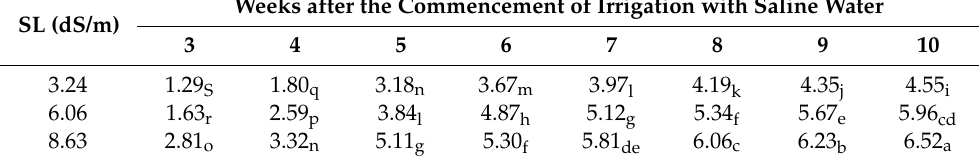
Table 5. Interaction effects of salinity levels (SLs) and weeks after commencement of irrigation with saline water (WAST) on electrical conductivity of the saturated soil extracts (EC se s, dS/m) in soybean rhizosphere. SL (dS/m)